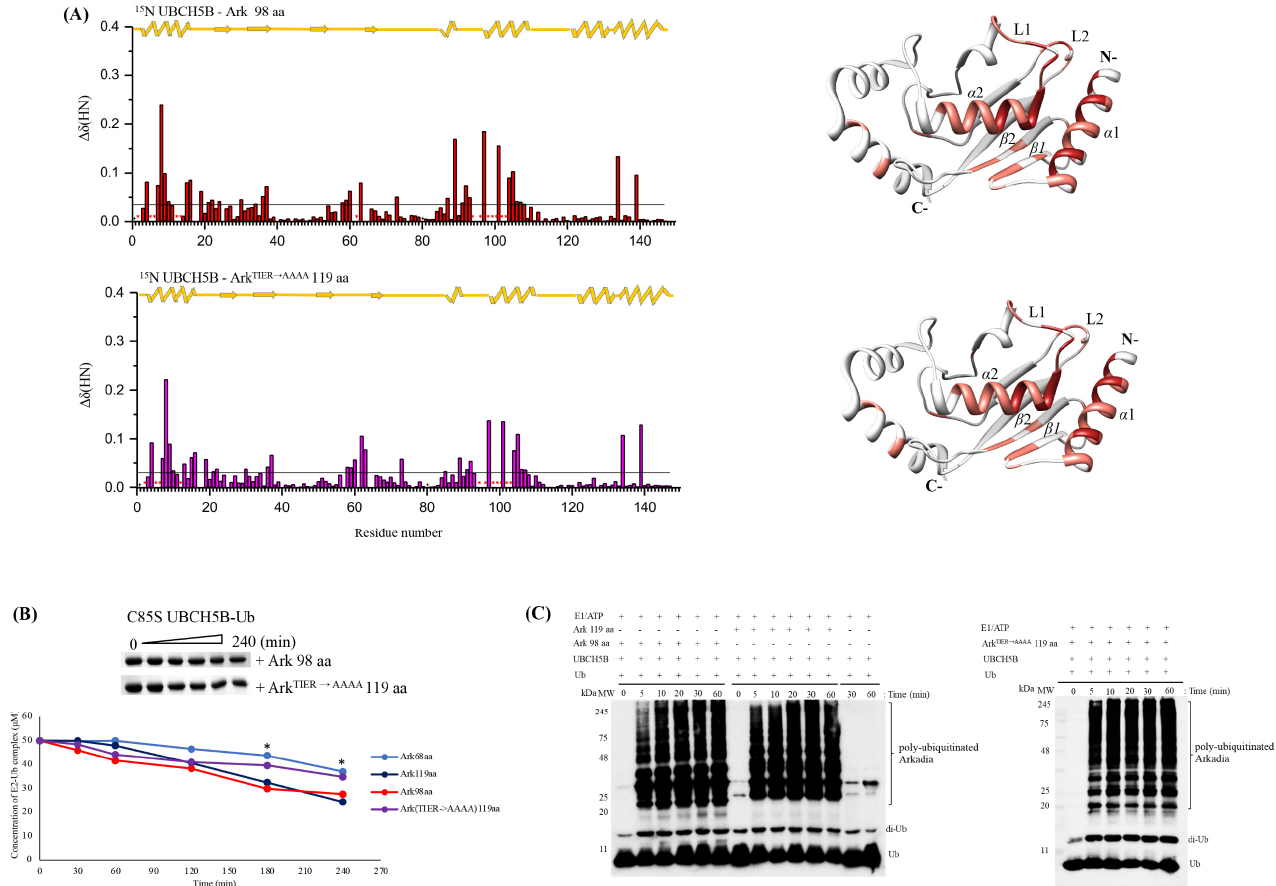
Figure 12. ( A ) Bar graphs of UBCH5B’s CSPs after addition of Arkadia Δ RING (98 aa) or Arkadi ‐ a TIER → AAAA (119 aa) polypeptides. *: Represents disappeared residues, +: represents residues with